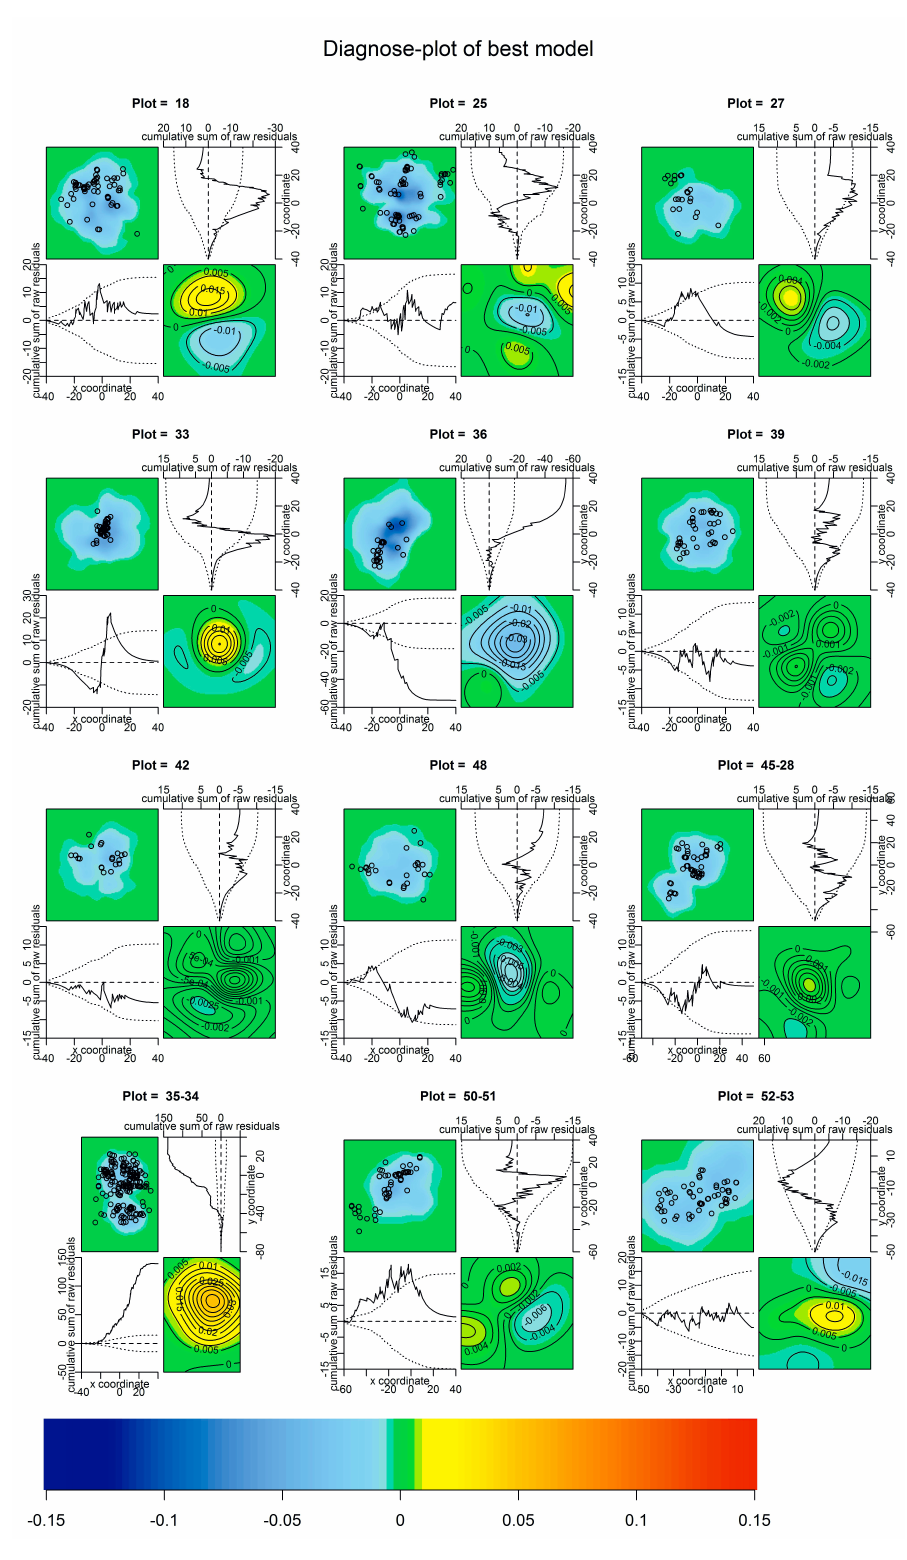
Figure A4. The plots display the residuals from the fitted model. As the model estimates a point density, the residuals are also densities. These plots can be used to assess goodness-of-fit, to identify